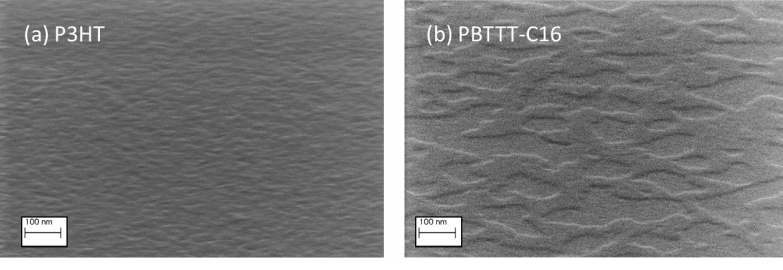
Figure 4. Topographical scanning electron microscope view of the two semiconductors: ( a ) P3HT and ( b ) PBTTT-C16. The probing e-beam was set with an acceleration voltage of 12 kV, a 10-µm aperture size and a 1.5-mm working distance. SEM images were acquired by tilting the samples at a 65° angle and using the in-lens (secondary electrons)